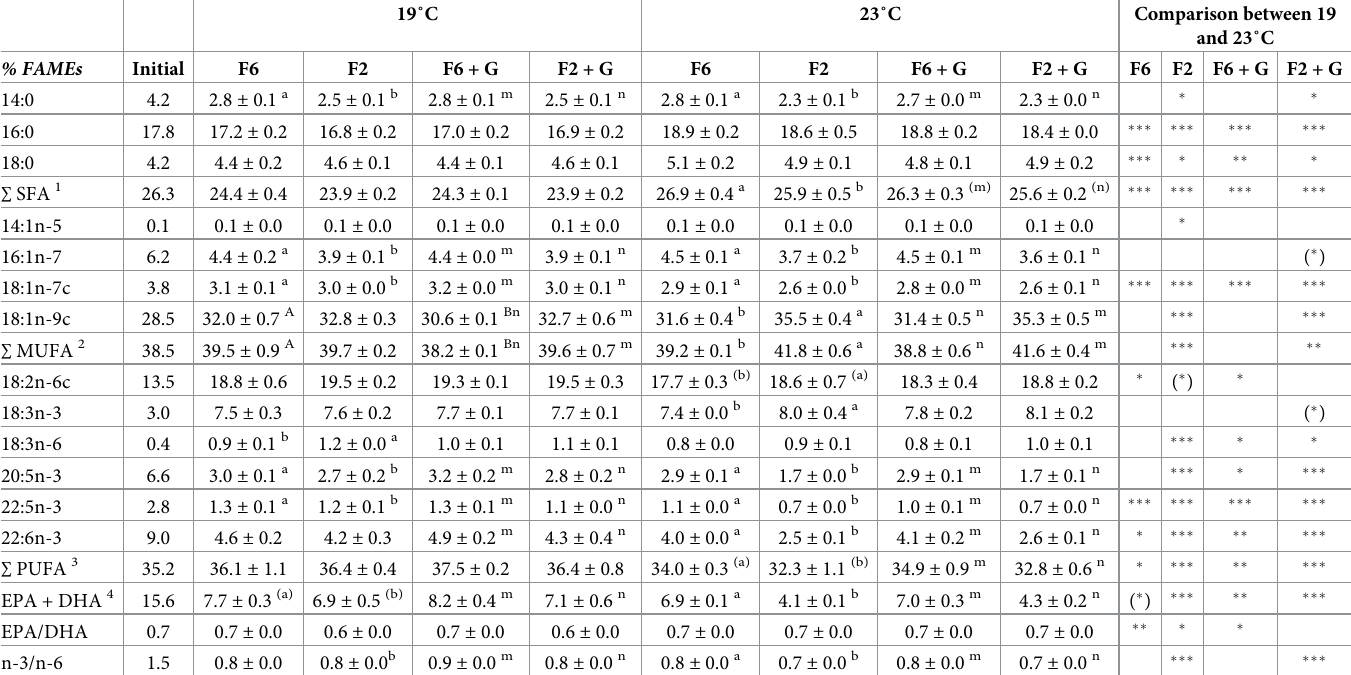
Table 5. Fatty acid composition (percentage of total fatty acid methyl esters (% FAMEs)) of whole body homogenate of gilthead sea bream at the end of the 8 week feeding trial held at two different temperatures (19˚C and 23˚C). F6 and F2 indicate the feeding with the control diets containing 6% and 2% DM fish oil, respectively. +G indicates feeding diets supplemented with 0.15% DM